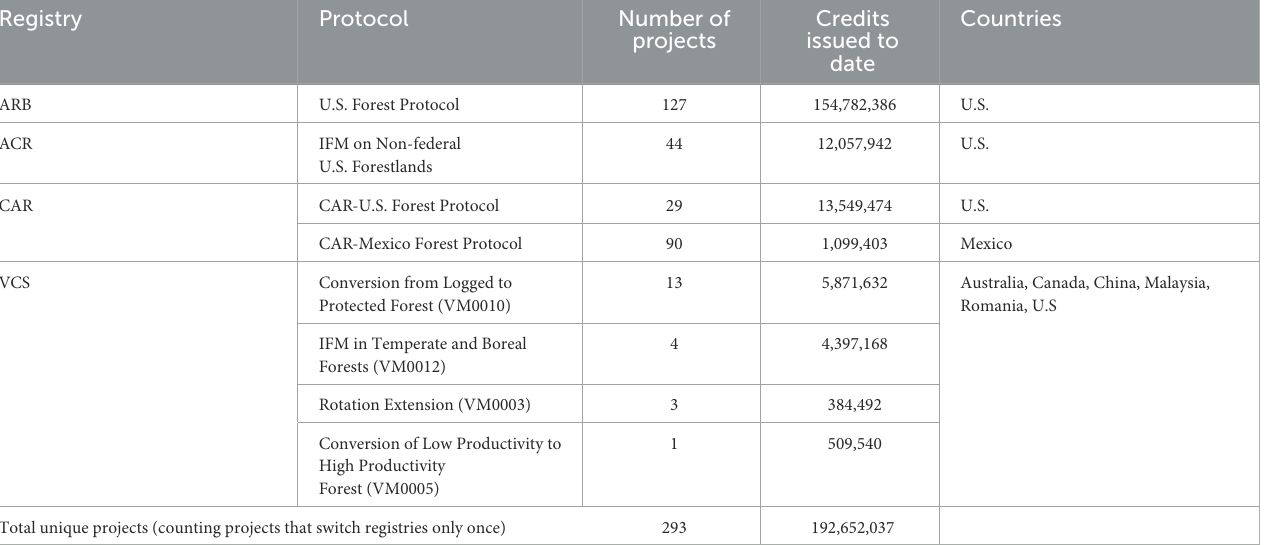
TABLE 1 IFM protocols